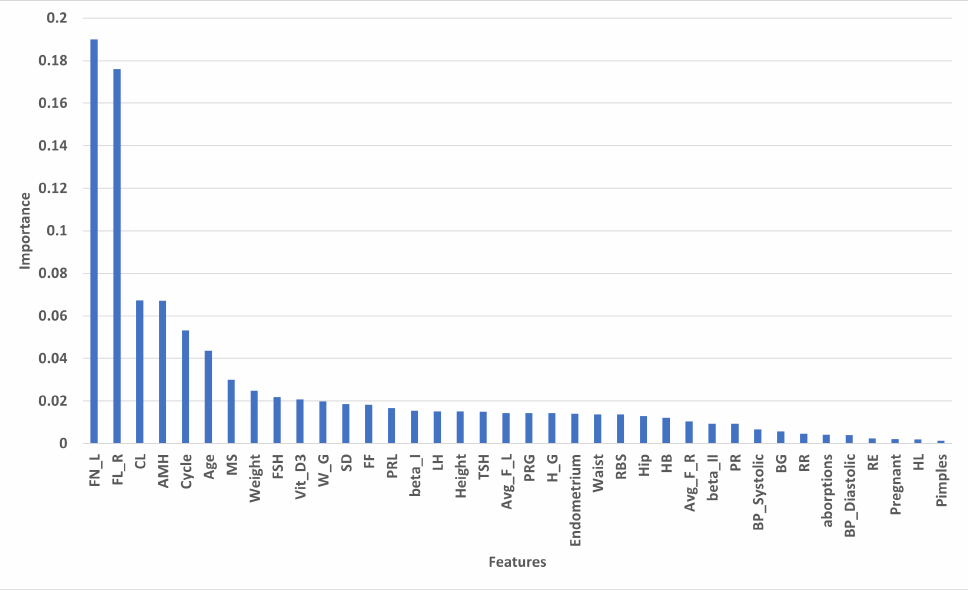
Figure 4. Sores of selected features by based tree.